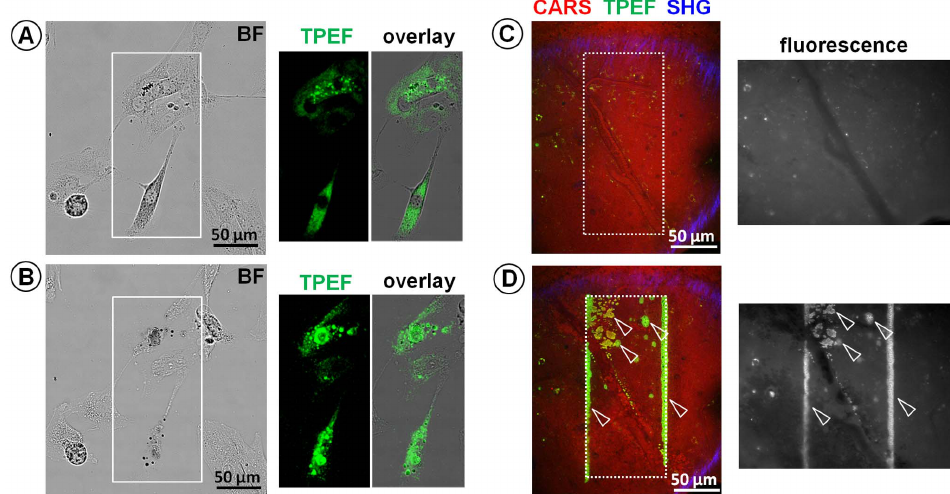
Figure 2. Effects of photodamage on living organisms during label-free multiphoton imaging. A : Bright field (BF) and TPEF image of the area in the box in the BF image acquired on living primary human glioblastoma cells in culture, and overly of BF and TPEF images. B : effects of a serial irradiation of 500 scans at laser power of , 52 mW in the area indicated by the box, leading to increase of TPEF in the cell cytoplasm. C: Label-free multiphoton image and fluorescence image (acquired using a mercury lamp for excitation) of mouse brain cortex; the brain surface is slightly convex, so that the image cuts through different tissue layers: CARS shows the cortical tissue with a blood vessel, while SHG shows the inner meningeal layer on top of the cortex. D: Label-free multiphoton image and fluorescence image acquired in the same region shown in C after 544 scans performed in vivo in the area indicated by the dotted line box; the arrows indicate the localized increase of fluorescence that matches the increase of TPEF.